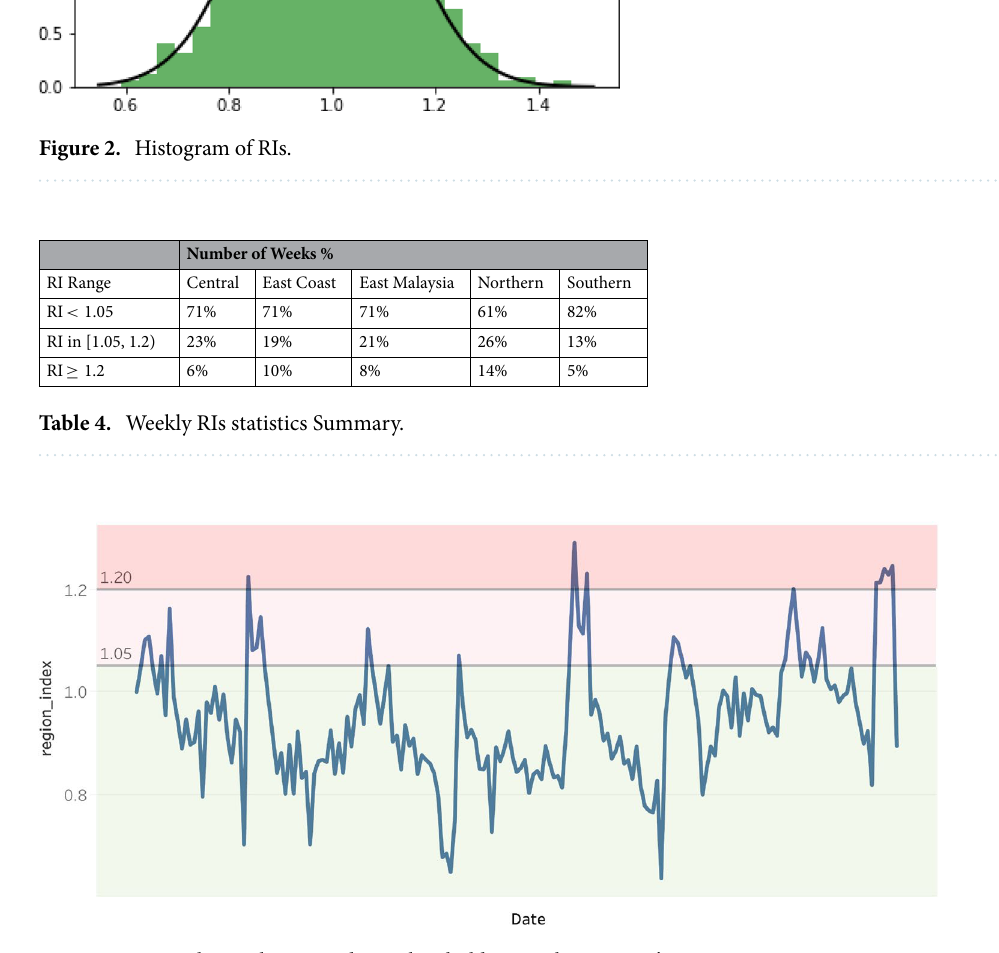
Figure 3. Example: Apply 70% and 90% threshold to Southern region’s